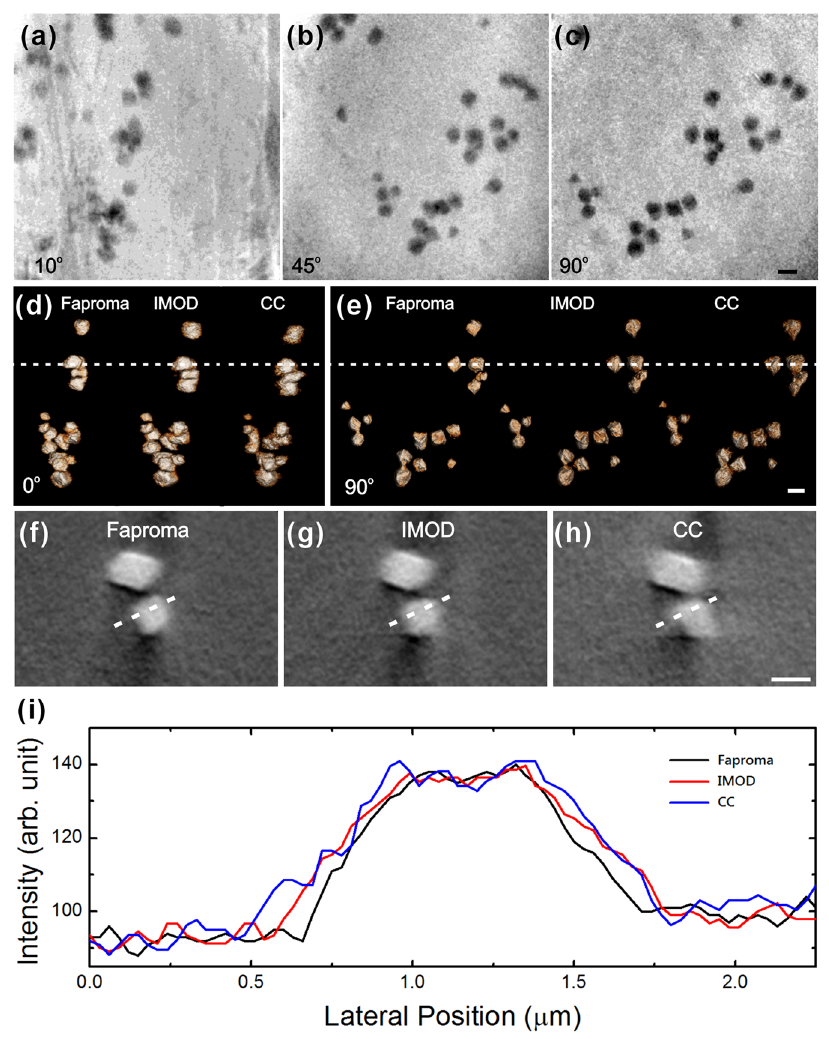
Figure 5. Synchrotron transmission X-ray microscopy (TXM) data processed by Faproma, IMOD and cross- correlation (CC) methods for correction comparison. ( a–c ) Raw TXM data obtained at 10°, 45°, and 90° azimuth angles. ( d–e ) 3D tomographies of globular pyrites observed from 0° and 90° azimuth angles that were reconstructed from projections, and corrected using the Faproma, IMOD, and CC methods, respectively. ( f–h ) Sections of the globular pyrite 3D tomographies, which were reconstructed using Faproma, IMOD, and CC correction, respectively. The 3D tomography by the Faproma method shows clearer boundaries than those by the IMOD and CC methods. In the IMOD case, 22 pyrite particles were tracked for alignment calculation. Comparisons of alignment and reconstruction quality among three methods are shown in Supplementary Movies S1 and S2. Line profiles were obtained along the white-dashed lines in ( f–h ). ( i ) Comparison of tomography resolution influences between the Faproma, IMOD, and CC methods. The line profile of the pyrite was obviously narrower and the edge response was sharper in the Faproma than that in IMOD and CC methods, which pointed to better projection registration and subsequent superior reconstruction quality and tomography resolution. The 3D rendering is shown using ORS Visual SI software (Object Research Systems Inc., Montreal, Quebec, Canada). Scale bar: 1 μ